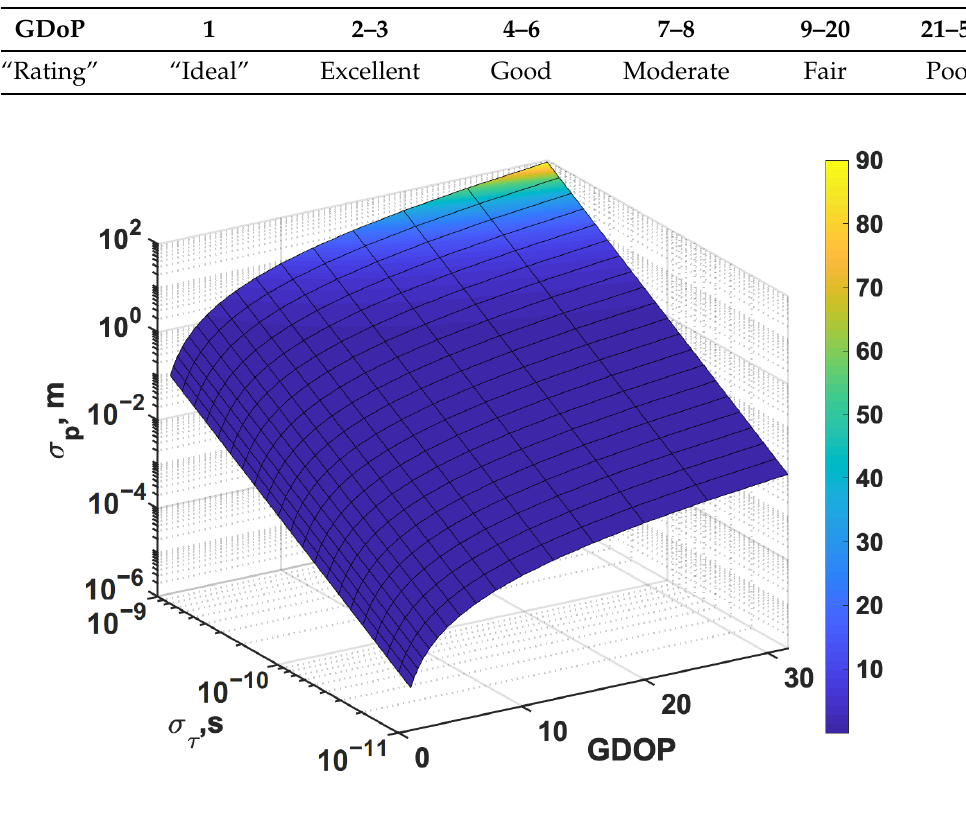
Table 2. Qualitative rating of realistic GDoP values.